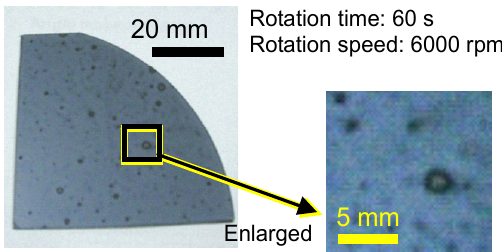
Figure 5. Photograph of nonuniform surface of polyurethane film.